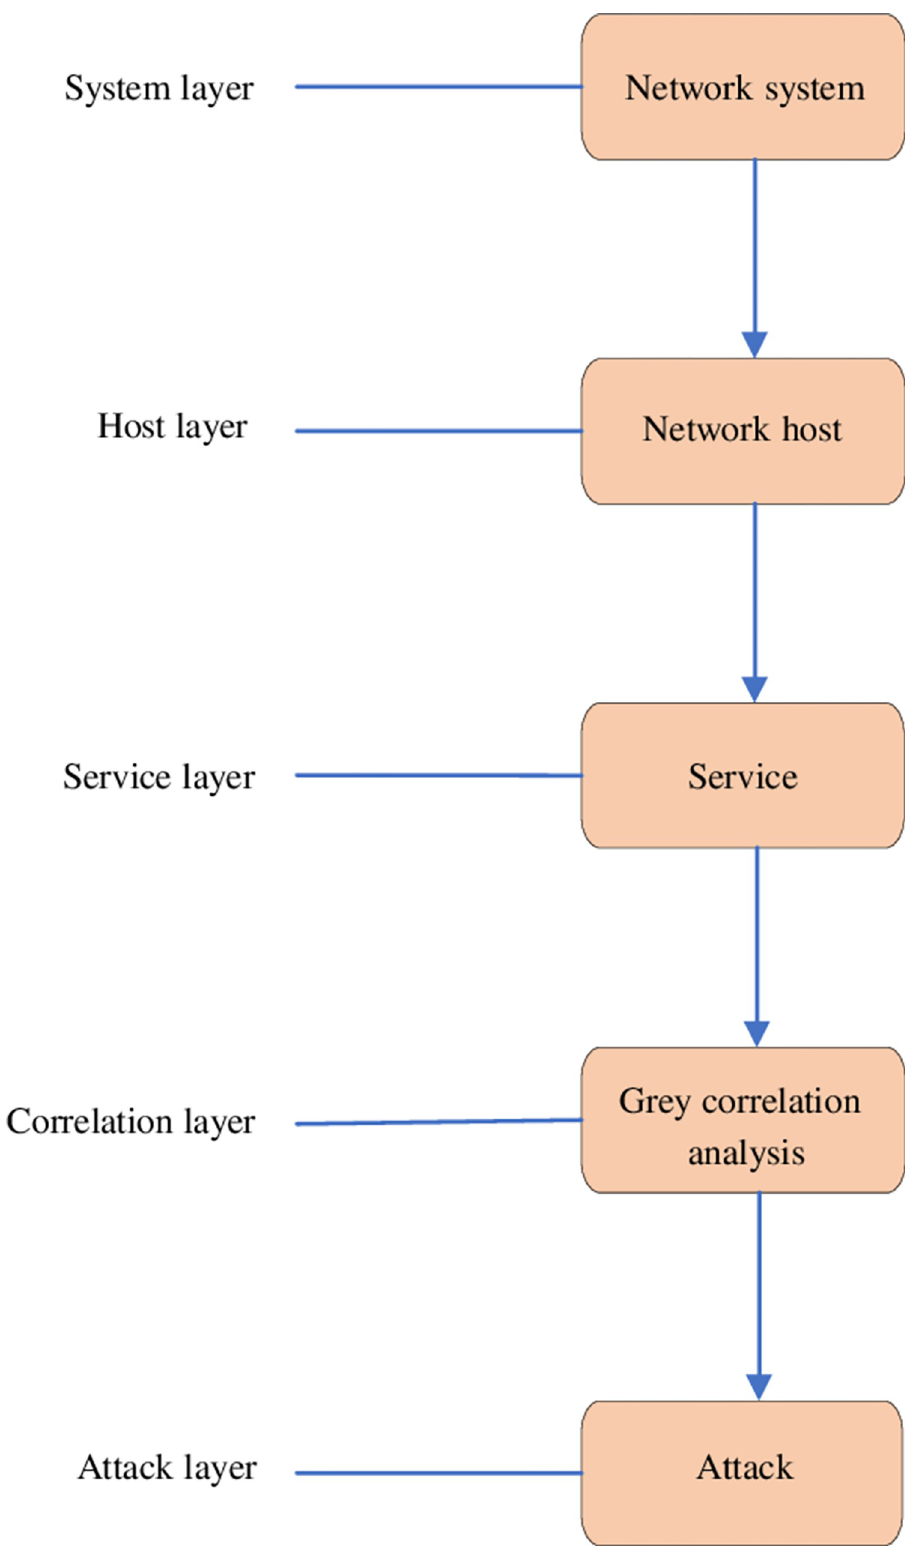
Fig 4. Structure of GRG-based